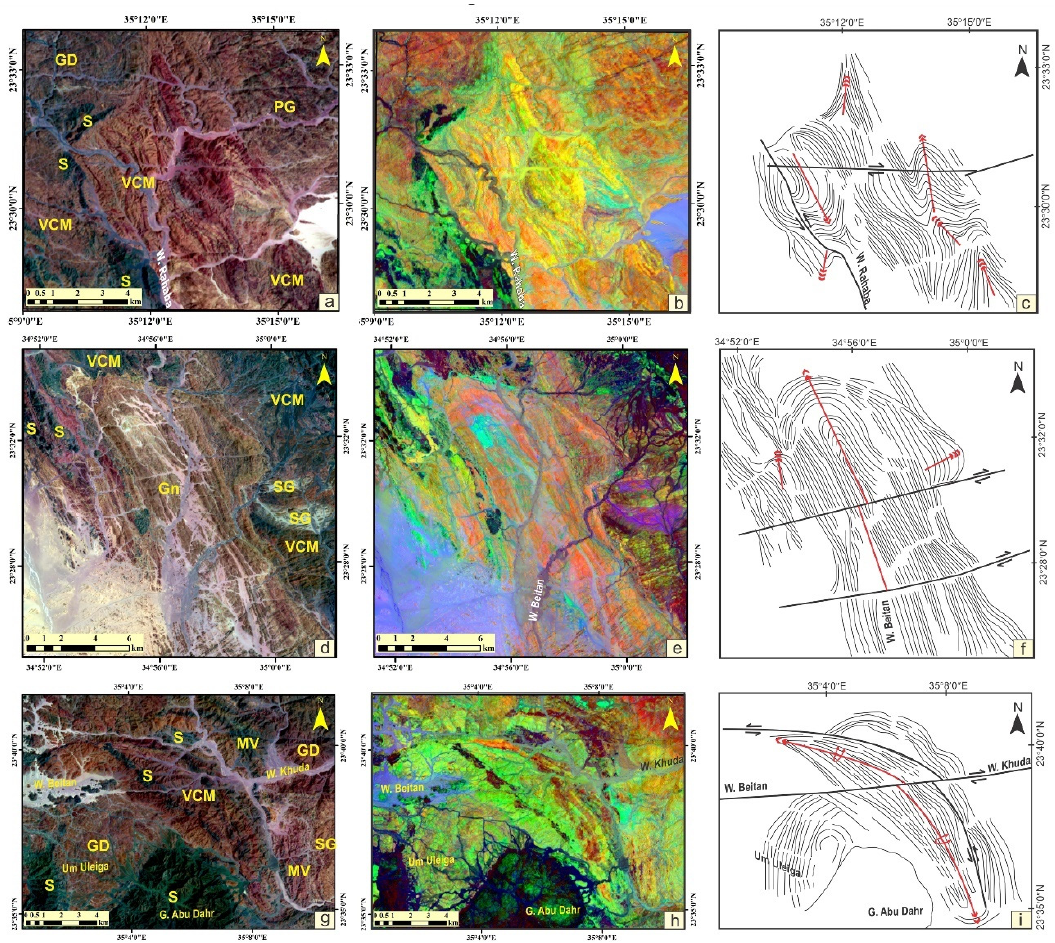
Figure 11. ( a,d,g ) Landsat-8 OLI band composites RGB-753, ( b,e,h ) Landsat-8 OLI band ratio RGB-7/6, 6/5, 4/2 highlighted the different folding types and trends, and ( c,f,i ) the resultant interpretation maps of the different fold generations (thin lines for foliation trajectories and red arrows lines are interpreted fold axial traces and major faults (black lines). Gn; gneisses, S; serpentinites, VCM; volcaniclastic metasediments, MV; metavolcanics, SG; syn-orogenic granites, GD; metagabbro–diorite complex, PG, post-tectonic granite.